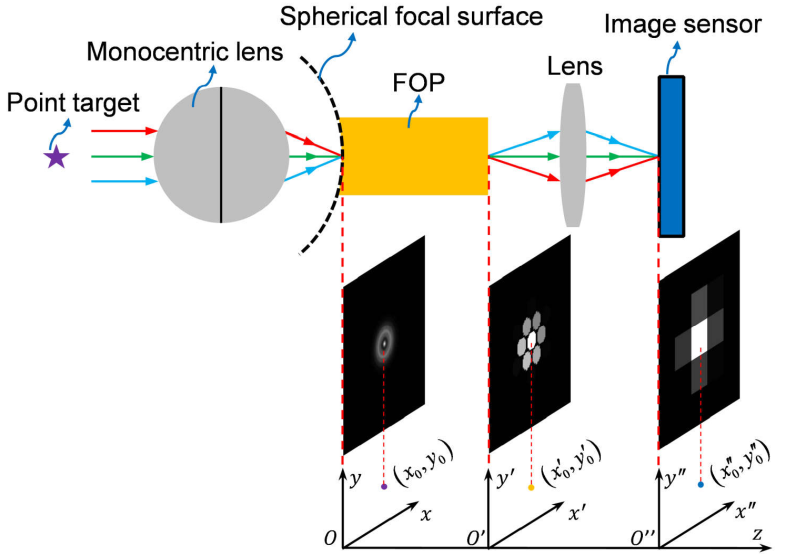
Figure 1. The two-stage discrete coupling model of a spherical focal surface (fiber optic plate—FOP) image sensor, establishing a rectangular coordinate system O - xy on the spherical focal surface and setting the centroid position of the imaging spot to ( x 0 , y 0 ) ; establishing a rectangular coordinate system O (cid:48) - x (cid:48) y (cid:48) on the FOP exit end surface and setting the centroid position of the imaging spot ) ; establishing a rectangular coordinate system O (cid:48)(cid:48) - x (cid:48)(cid:48) y (cid:48)(cid:48) on the image sensor surface and to ( x (cid:48) , y (cid:48) 0 0 setting the centroid position of the imaging spot to ( x (cid:48)(cid:48)